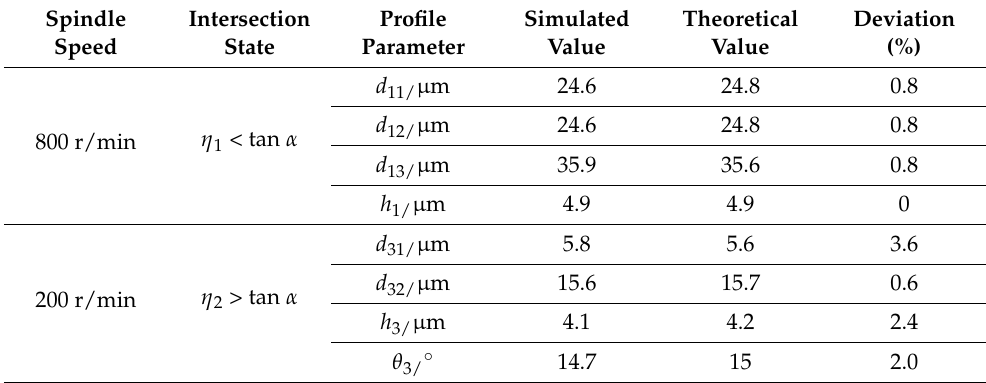
Table 2. Comparison of the simulated and theoretical values of dimple profiles, under spindle speeds of 800 and 200